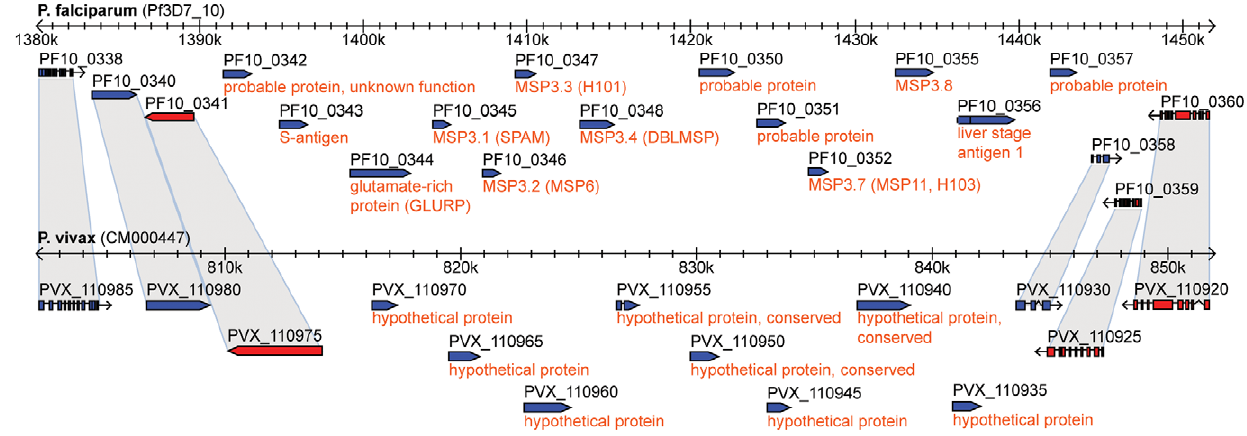
Figure 8. Uncharacterized genes on P.vivax chromosome 6 possibly involved in erythrocyte invasion. The upper part of the figure shows a genomic region on P. falciparum chromosome 10 with a cluster of 13 P. falciparum -specific genes, including the S-antigen, liver stage antigen 1 (LSA1), and five members of the MSP3 gene family, including MSP6. The lower part of the figure shows the syntenic genomic region on P. vivax chromosome 6 containing a cluster of eight P. vivax hypothetical proteins. Shaded segments indicate orthology. Genes on the forward strand are shown in blue, genes on the reverse strand shown in red. Figure adapted from PlasmoDB 8.0.